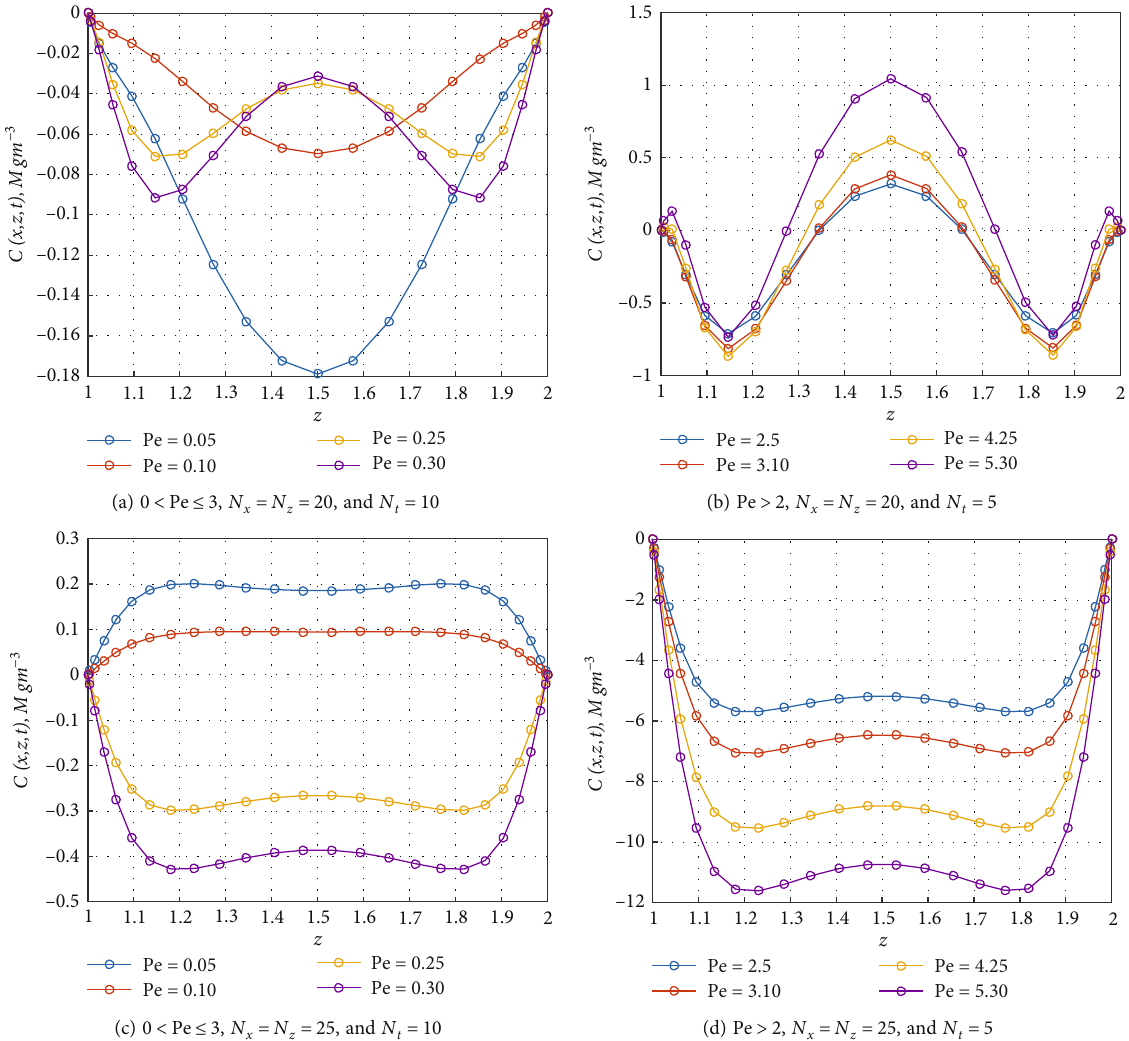
Figure 2: E ff ect of varying local Pe on the distribution of solute concentration pro fi le at di ff erent collocation